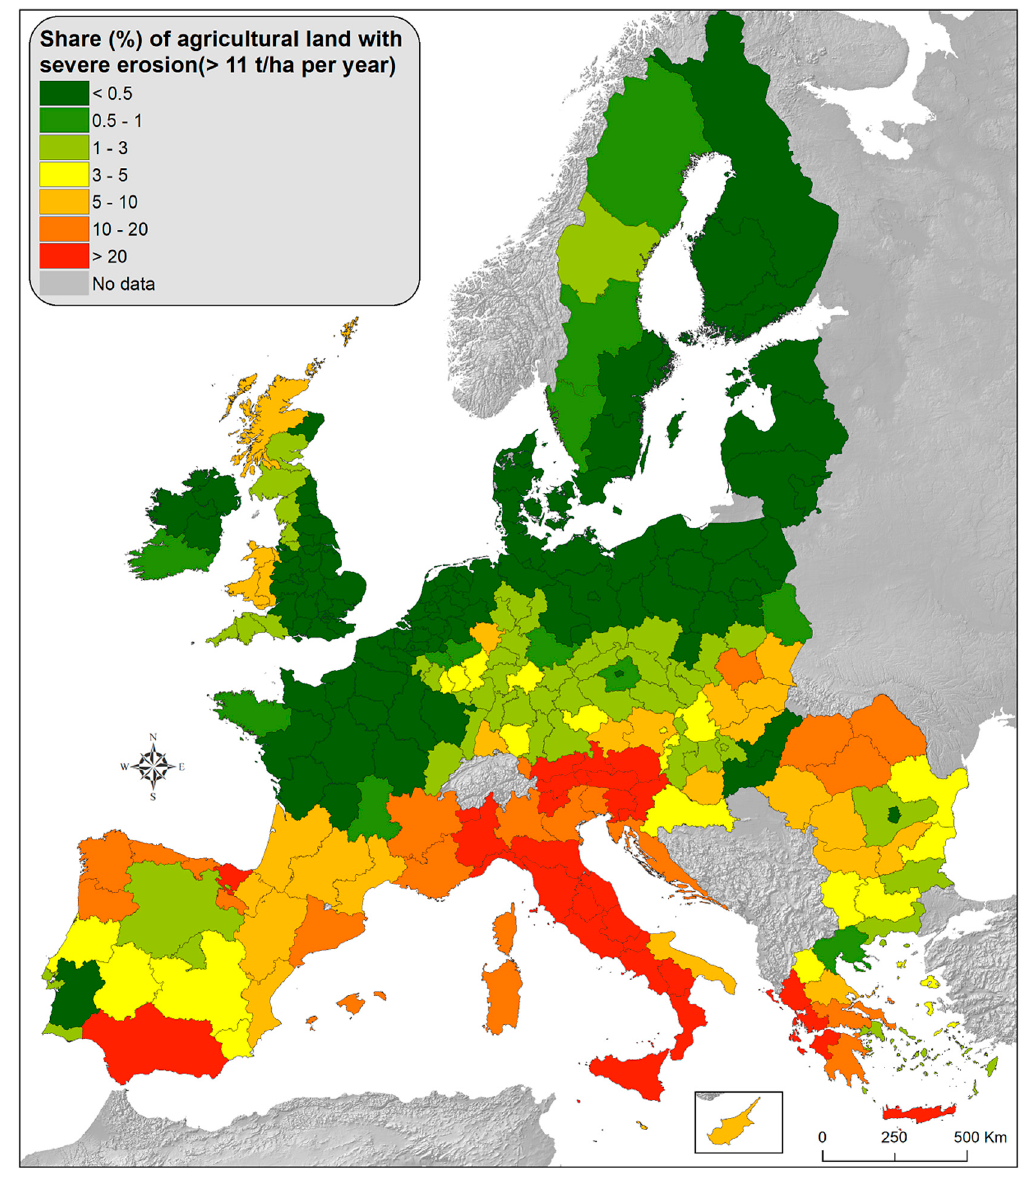
Figure 4. Indicator “percentage of agricultural area affected by severe erosion (>11 t ha -1 yr -1